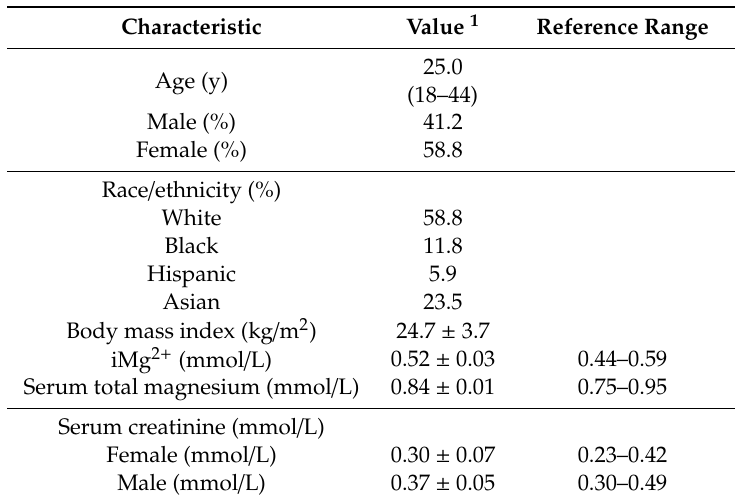
Table 1. Baseline characteristics of the study participants ( N =